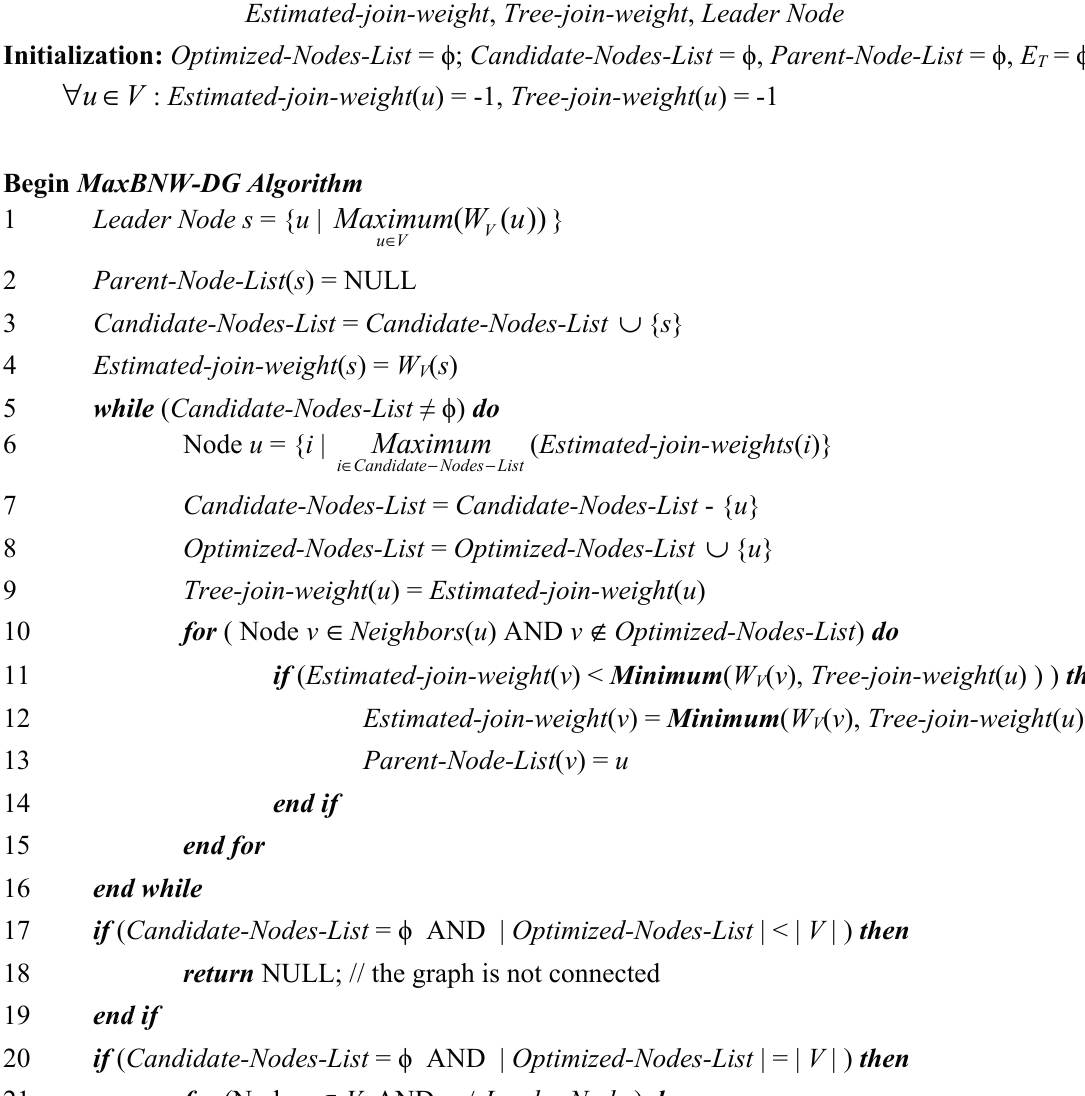
Algorithm 1. Pseudo Code for the Algorithm to Determine Maximum Bottleneck Node Weight-DG